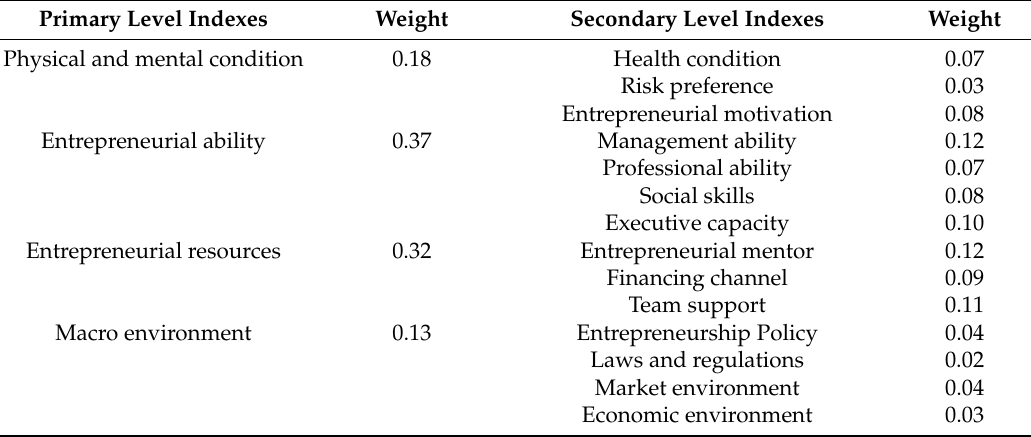
Table 4. Indexes weight.